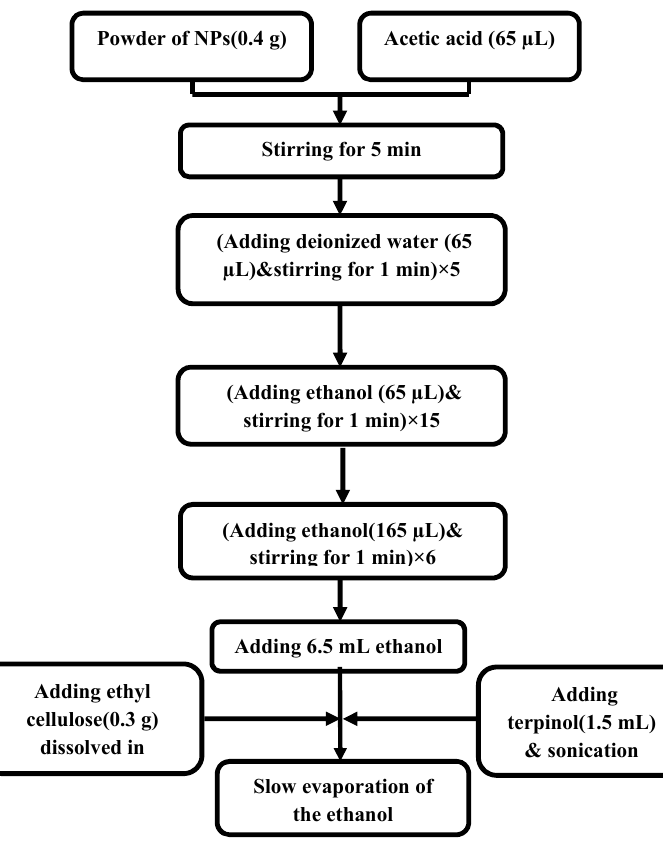
Fig.1. Flow chart for preparation of iron oxide nanoparticles